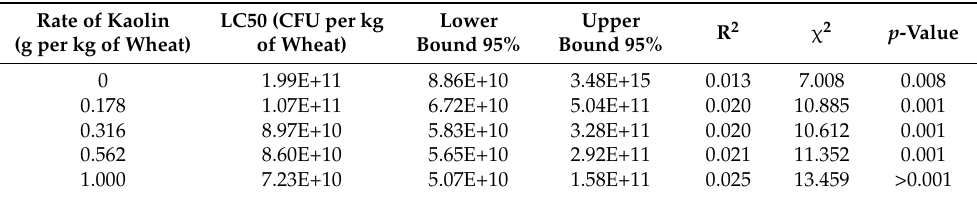
Table 3. Results of logistic regression on Tribolium confusum adult mortality data for each rate of kaolin in dose response bioassay 3.